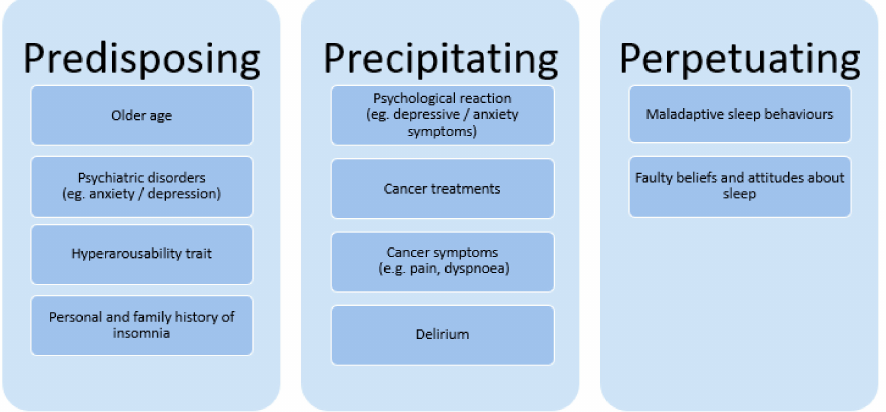
Figure 1. Insomnia in the context of advanced cancer. Examples of predisposing, precipitating, and perpetuating factors involved in the development of insomnia in advanced cancer